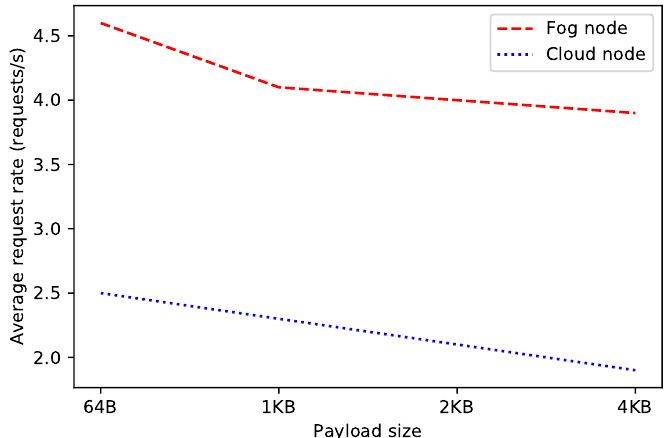
Figure 10. Average request rate for OrbitDB when running on fog and cloud